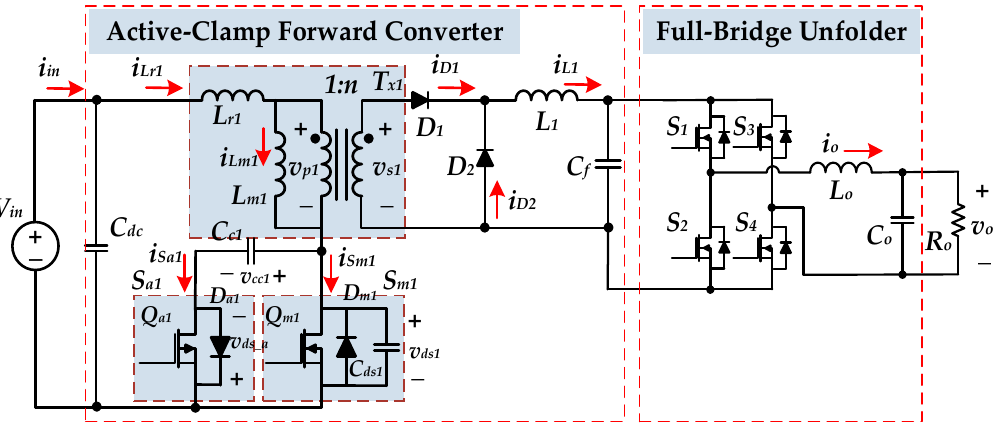
Figure 4. The circuit configuration of the proposed active-clamp forward inverter.